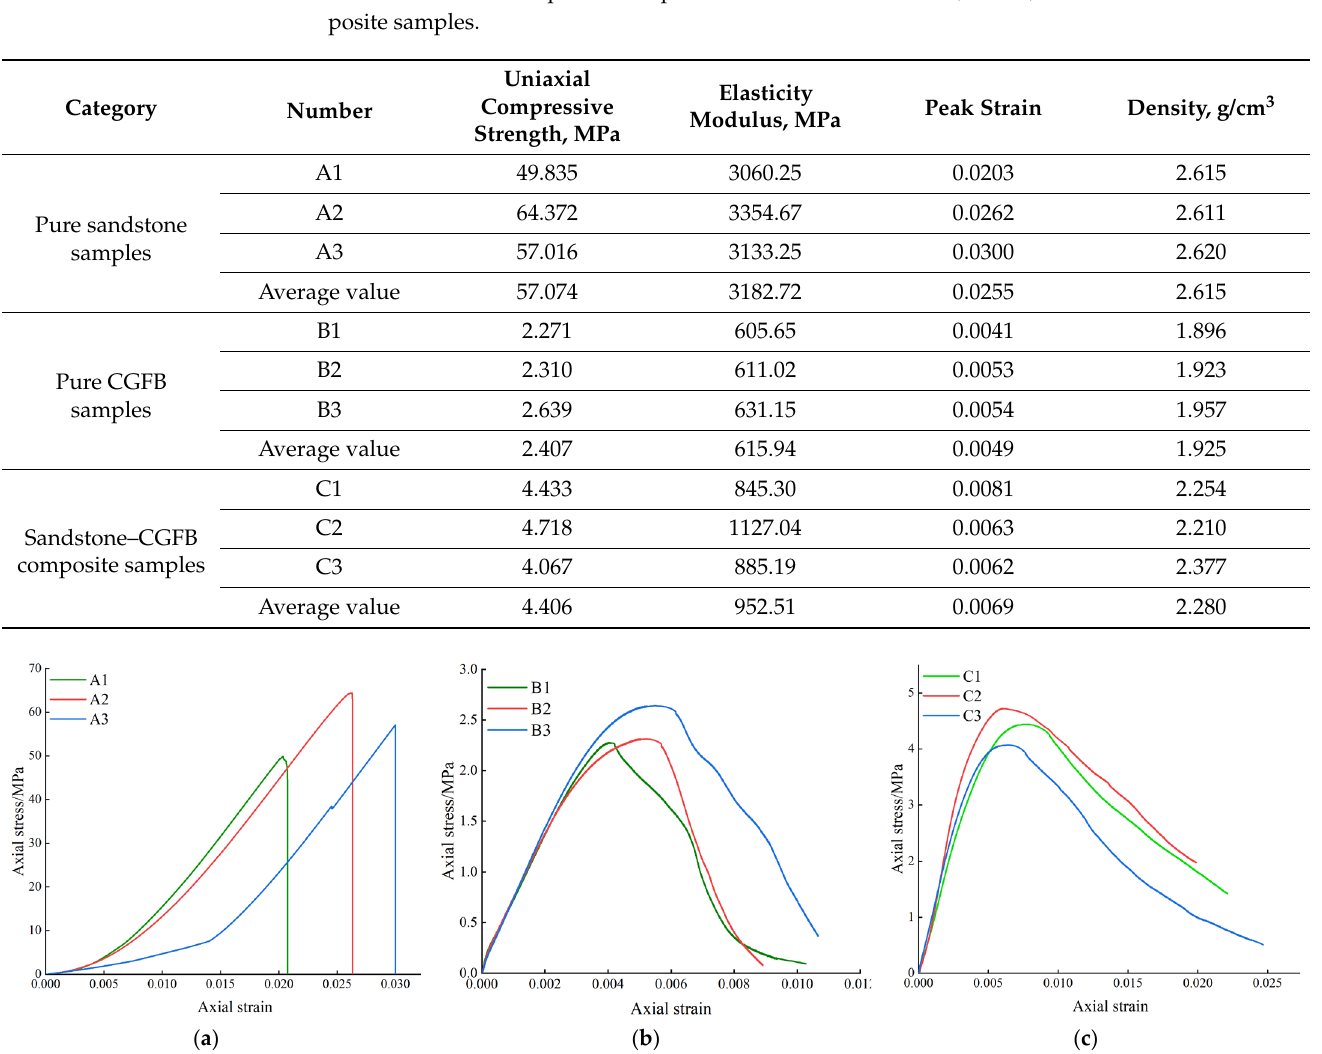
Figure 6. Comparison of uniaxial compressive strength, elastic modulus, and peak strain. ( a ) Uni- axial compressive strength; ( b ) elastic modulus; ( c ) peak strain.